Question: From the figure, is the trend upward or downward?
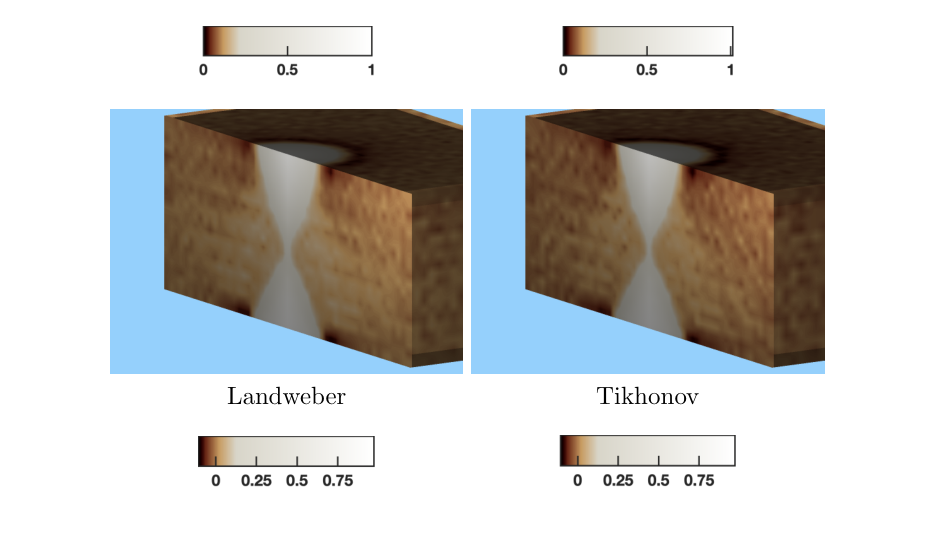
Answer: increasing